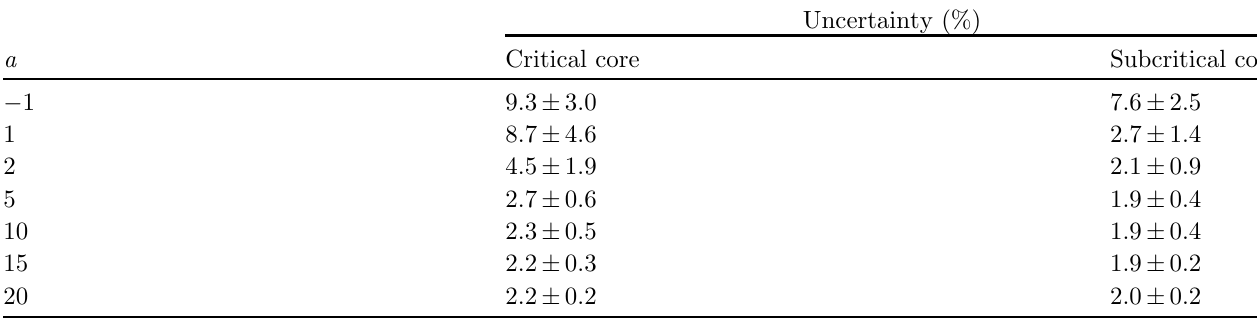
uncertainty with different scaling factors. eff